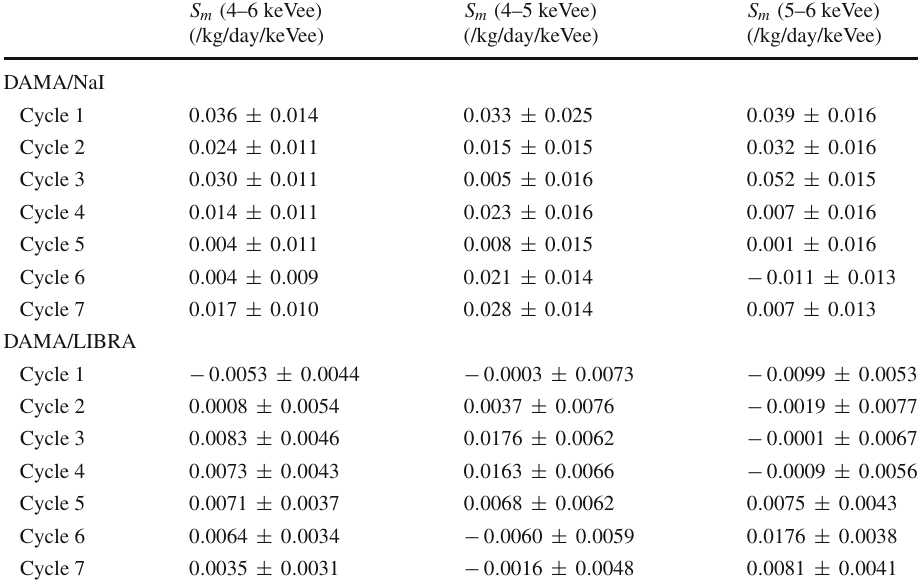
S m (4–6 keVee) (/kg/day/keVee)